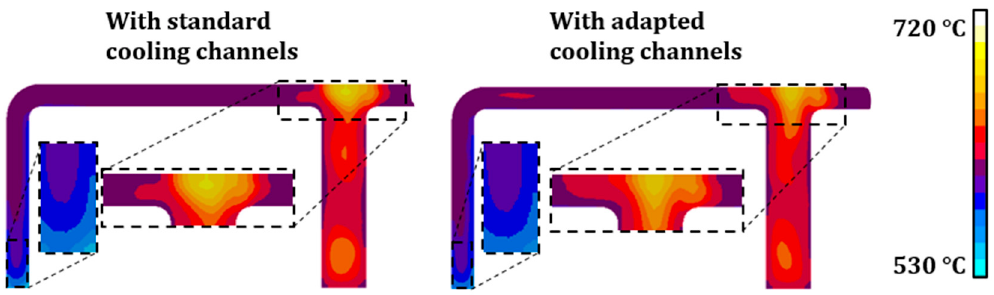
Figure 9. Temperatures at the end of pouring in the mid-plane of the cast part (U-section).